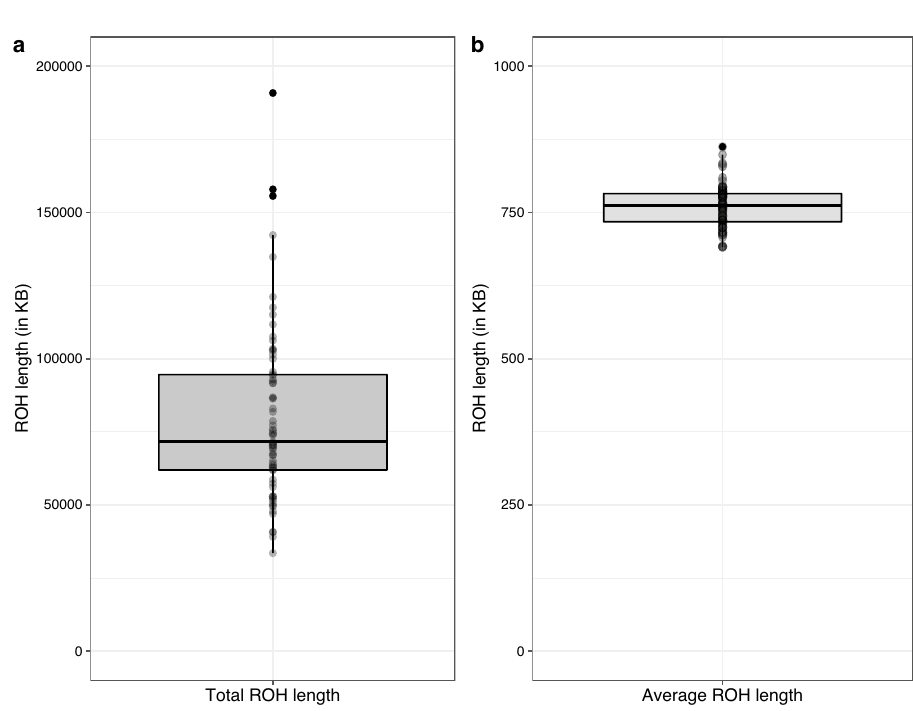
Figure 3. The distribution of the runs of homozygosity (ROH) lengths (kilobase pairs) of genomes in 71 African wild dogs ( Lycaon pictus ) from Kruger National Park (KNP), South Africa. ( a ) The total length of the ROH segments. ( b ) Average length of the ROH